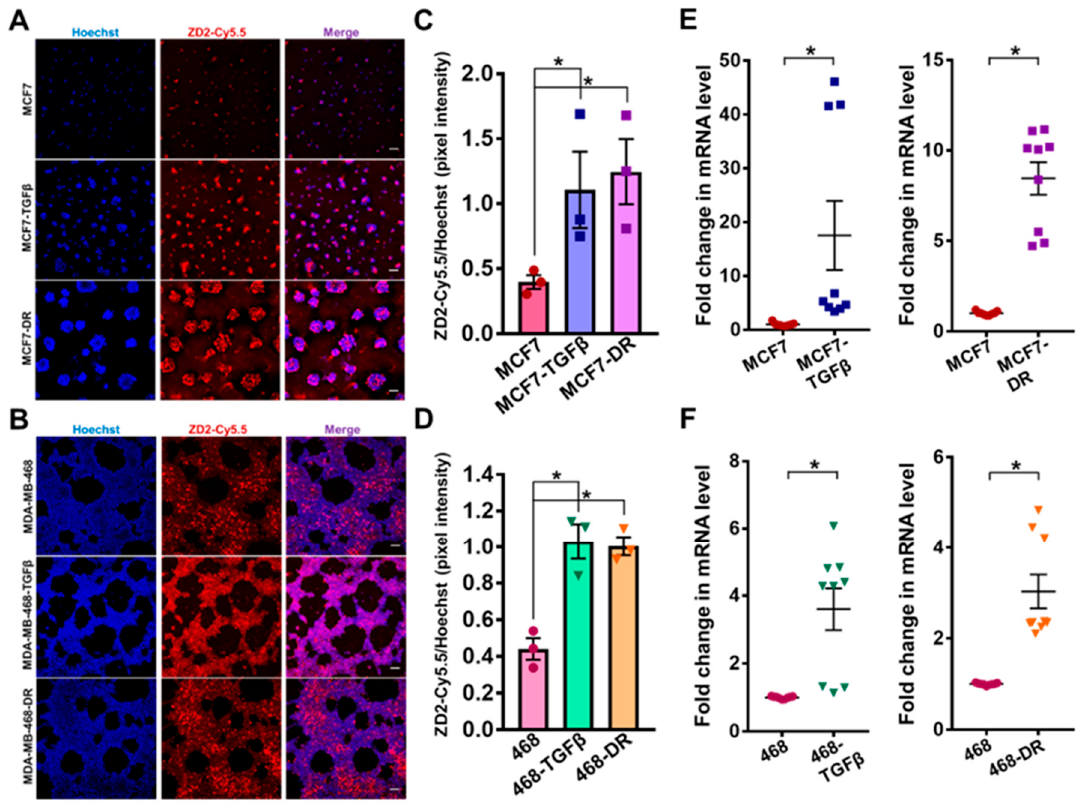
Figure 3. Increased EDB-FN expression in breast cancer cells with TGF- β treatment and drug resistance. ZD2-Cy5.5 staining of 3D cultures of breast cancer cells shows significantly increased EDB-FN expression in ( A ) MCF7-TGF- β and MCF7-DR and ( B ) MDA-MB-468-TGF- β and MDA-MB-468-DR cells, compared to the parent MCF7 and MDA-MB-468 cells, respectively. ZD2 peptide binding to EDB-FN was quantified in FIJI as the ratio of the pixel intensities of ZD2-Cy5.5 to that of Hoechst to show increased EDB-FN level in ( C ) MCF7-TGF- β and MCF7-DR and ( D ) MDA-MB-468-TGF- β and MDA-MB-468-DR cells, compared to the parent MCF7 and MDA-MB-468 cells. Bars denote mean ± sem and dots denote independent replicates. * p < 0.05 using Mann–Whitney U test. qRT-PCR analysis shows significantly upregulated mRNA expression of EDB-FN in ( E ) MCF7-TGF β and MCF7-DR